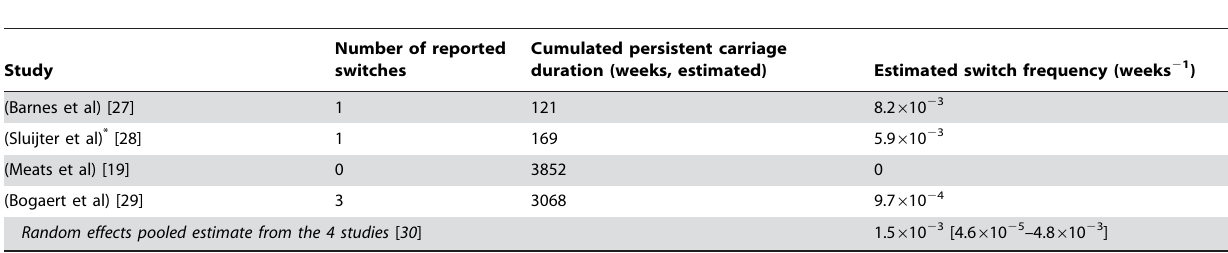
Table 1. Estimation of the switch frequency (weekly probability for a persistently carried pneumococcal strain to switch its capsule).